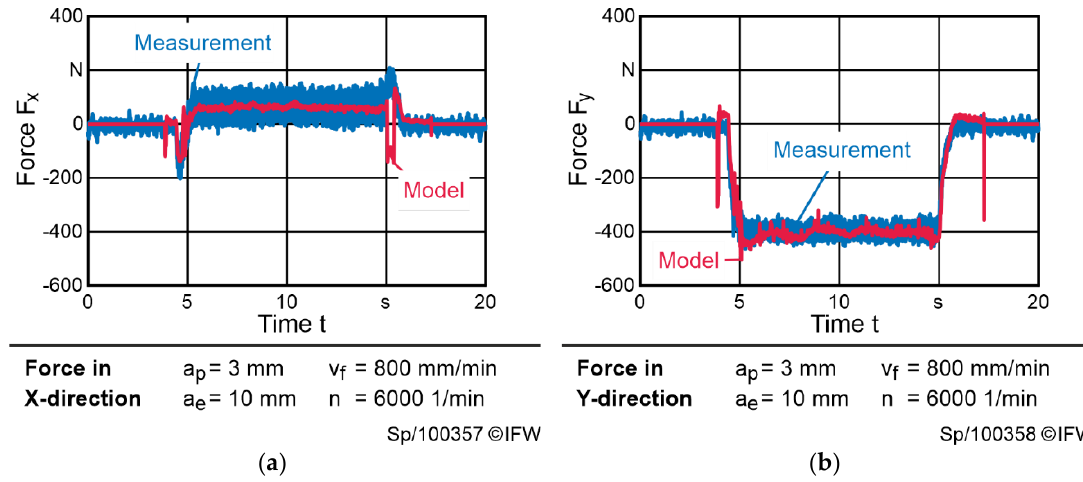
Figure 4. Comparison between measured process forces and the model-based approach during milling of a diagonal groove: ( a ) force acting in X -direction (root mean square error (RMSE) = 36.22 N); ( b ) force acting in Y -direction (RMSE = 28.25 N).